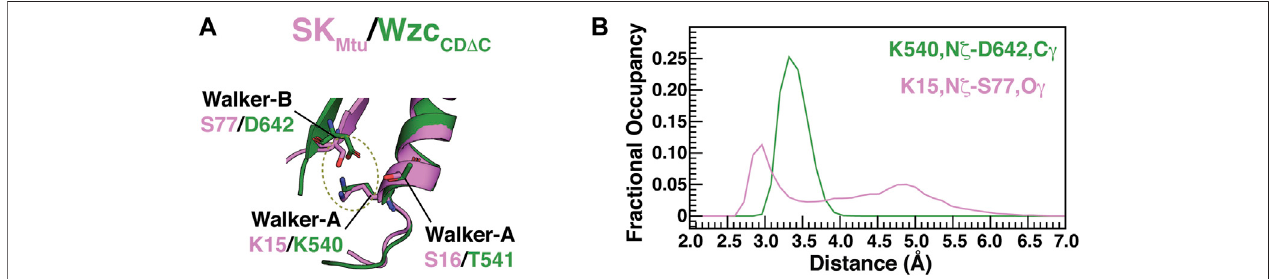
FIGURE2| (A) Interactionsthat arecharacteristic oftheopen states ofBY-kinases (OS) and SKs (WOS). S77from the degraded Walker-Bmotif from SK Mtu (pink) occupies approximately the same spatial position as the Walker-B D642 from Wzc CD Δ C (green) allowing the formation of a S77-K15 hydrogen bond reminiscent of the D642-K540 interaction in Wzc CD Δ C . (B) Distribution of the K540,N ξ -D642,C γ (green) and K15,N ξ -S77,O γ (pink) distances from the REST2-generated ensembles of unliganded Wzc CD Δ C and SK Mtu ,